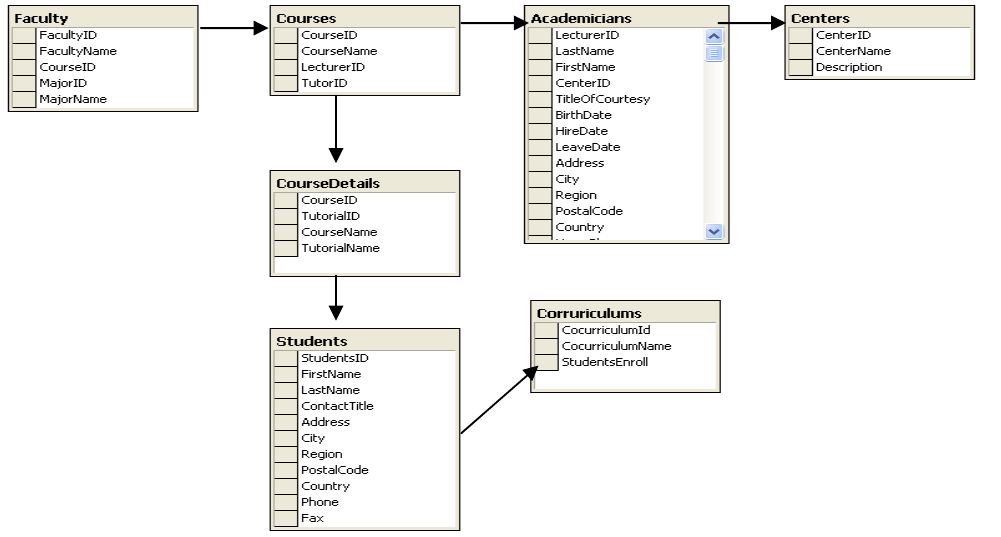
Figure 2: Mobile E-Learning Database